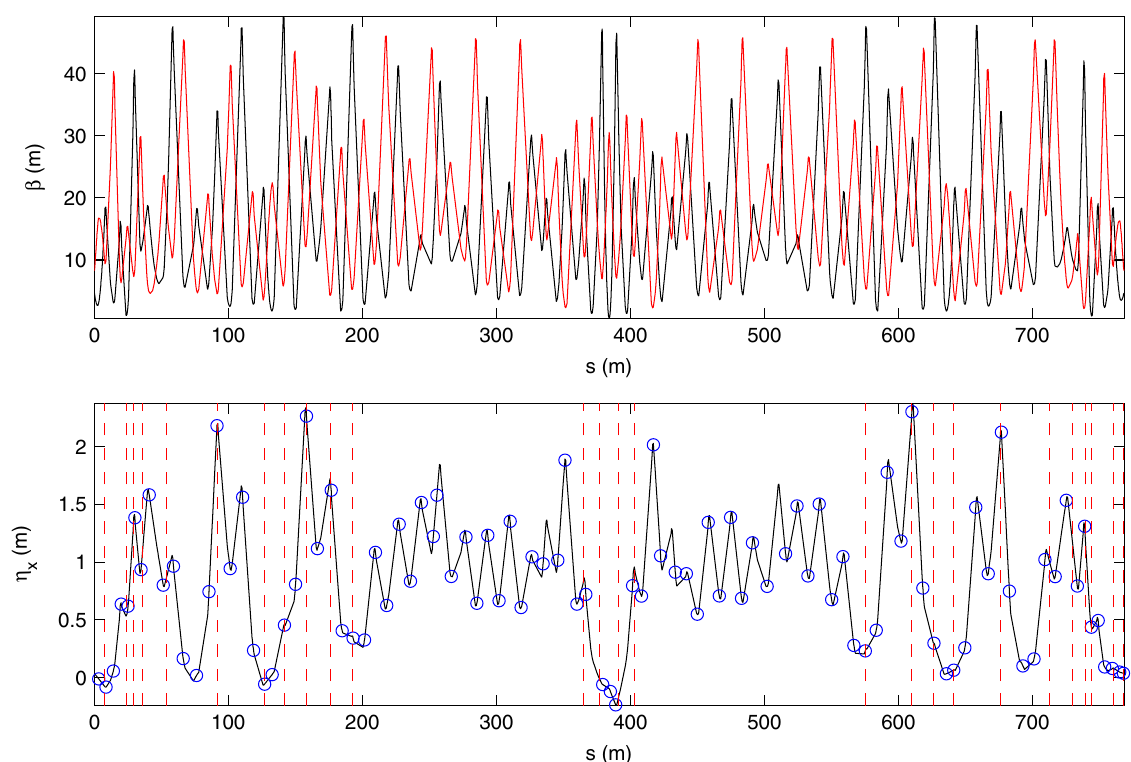
FIG. 2. Lattice functions in CesrTA. Top: horizontal (black) and vertical (red) beta functions. Bottom: horizontal dispersion, with BPM locations indicated by blue circles, and skew quadrupole locations indicated by vertical dashed